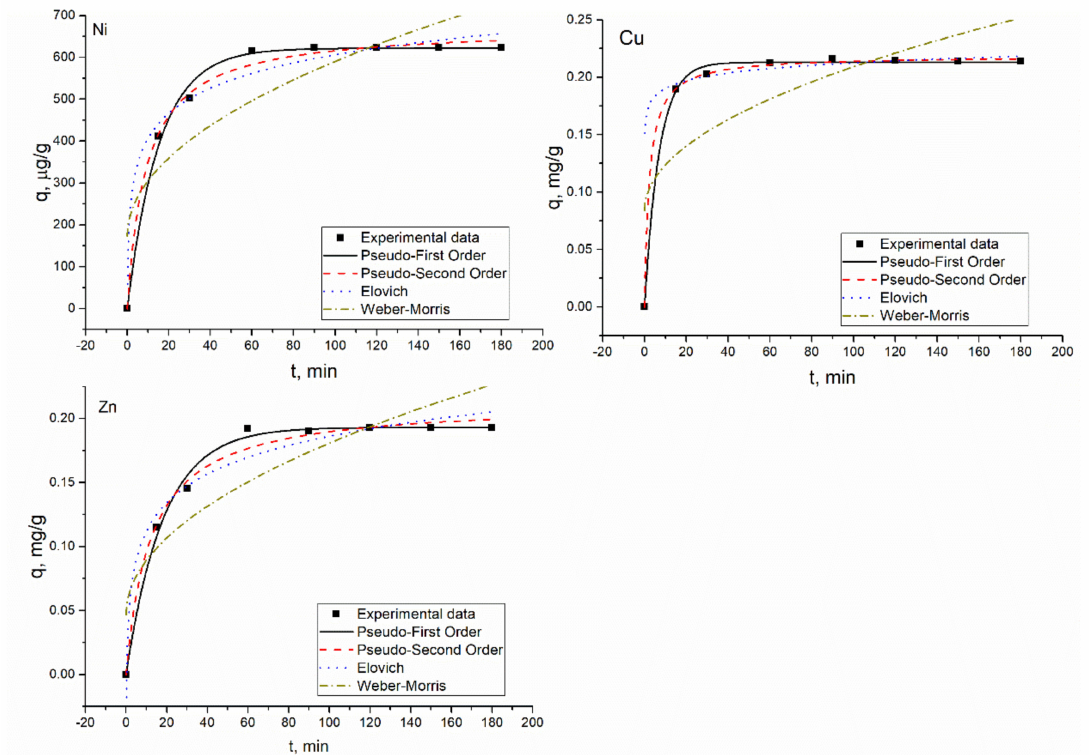
Figure 7. Metal adsorption on hybrid adsorbent in the Ni(II)-Zn(II)-Mo(VI)-Cu(II)